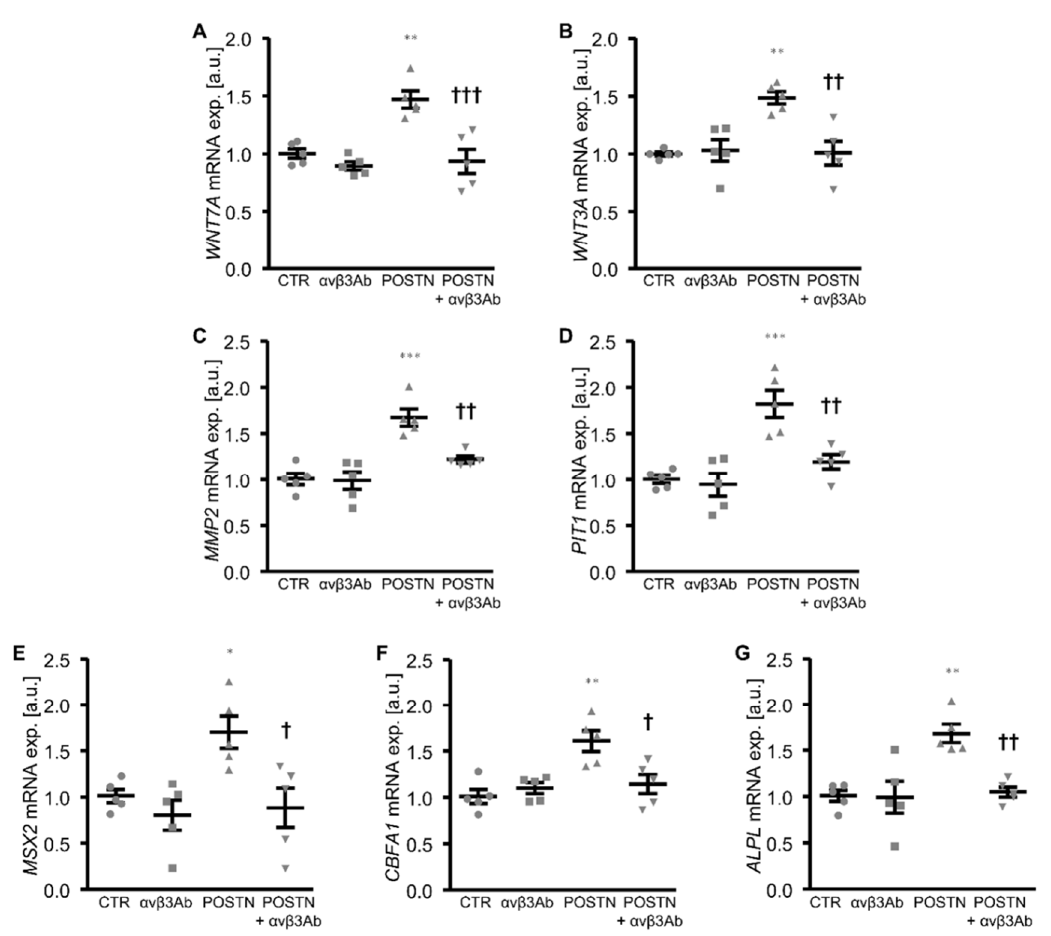
Figure 5. Treatment with integrin α v β 3 antibody blunts periostin-induced WNT/ β -catenin and osteogenic signaling in HAoSMCs. ( A – G ) Relative mRNA expression of WNT7A ( A ), WNT3A ( B ), MMP2 ( C ), PIT1 ( D ), MSX2 ( E ), CBFA1 ( F ) and ALPL ( G ) in HAoSMCs treated with control (CTR) or recombinant human periostin (POSTN) and with mouse IgG as control or integrin α v β 3 antibody ( α v β 3Ab). * p < 0.05; ** p < 0.01; *** p < 0.001 (significant difference versus CTR group); † p < 0.05; †† p < 0.01; ††† p < 0.001 (significant difference versus POSTN group).